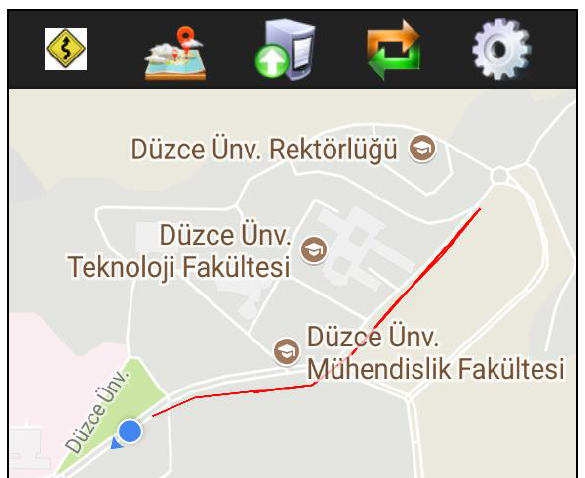
Figure 6. Displaying field team’s route to obtain road